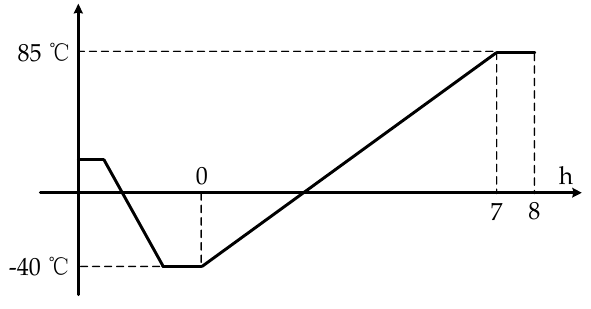
Figure 8. Flow chart of temperature experiment.